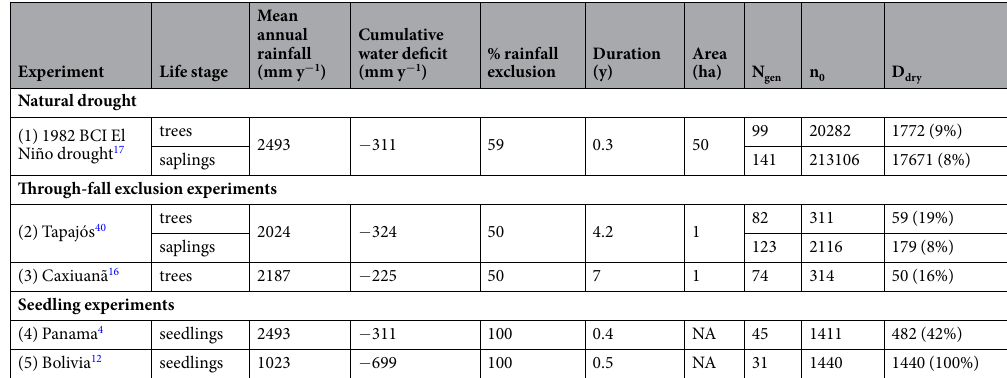
Table 1. Description of through-fall exclusion experiments and field observations analysed in this study. N gen represents the number of genera examined in each drought experiment; n 0 is the number of individuals before the drought in the droughted area. D dry shows the number of deaths during the drought. Life history stage represented by trees ( ≥ 100 mm diameter), saplings (10–99 mm D in BCI and 20–99 mm in Tapajós), and